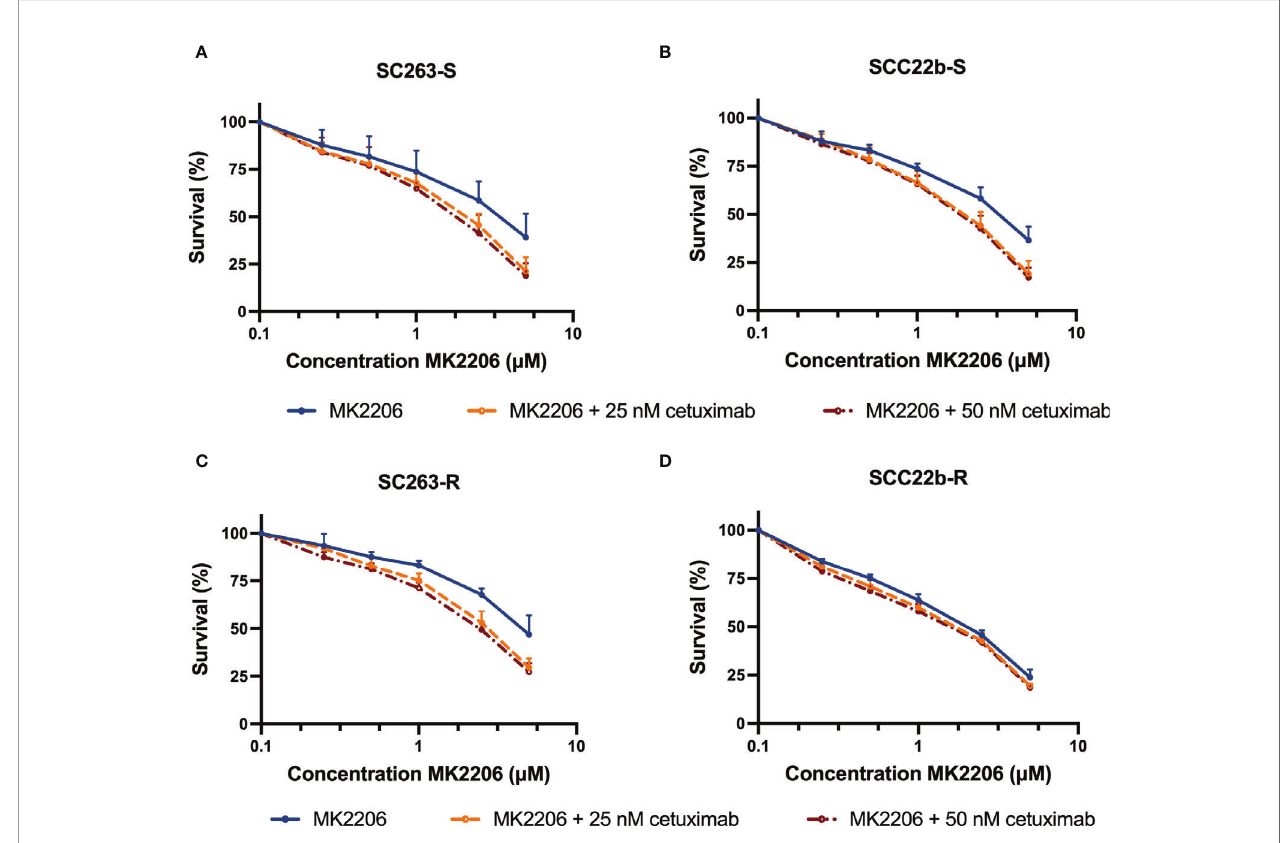
FIGURE 3 | The cytotoxic effect of cetuximab plus MK2206 with a total treatment duration of 72h. Dose-response curves for the cetuximab sensitive HNSCC cell lines SC263-S (A) and SCC22b-S (B) show a synergistic effect. Regarding the acquired cetuximab resistant variants, dose-response curves indicate a synergistic and additive effect in SC263-R (C) and SCC22b-R (D) , respectively. Survival curves were corrected for the cytotoxic effect of cetuximab alone. Cells were treated with fi xed concentrations of cetuximab, which were chosen based on the outcome of previous monotherapy experiments. Suf fi x -S: cetuximab sensitive cell line and suf fi x -R: acquired cetuximab resistant cell